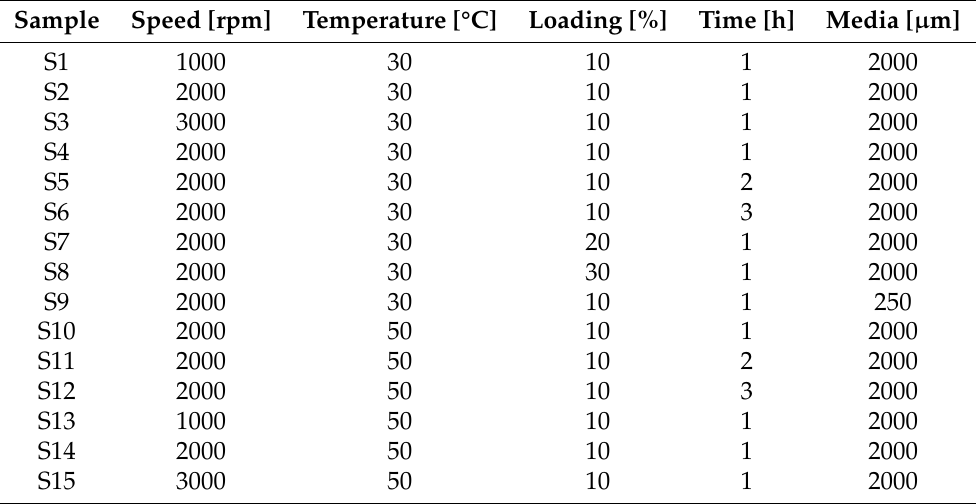
Table 1. Selected milling and synthesis parameters for each sample